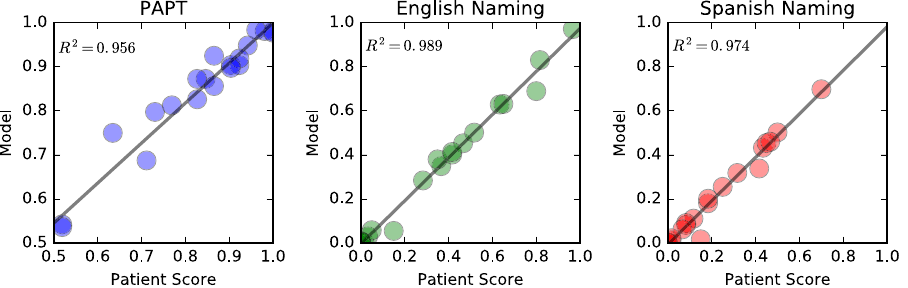
Figure 4. Individual pre-stroke models for each patient are lesioned to match diagnostic scores as accurately as possible. Real vs. simulated scores for all 13 patients are shown for the PAPT test (left), and English (middle) and Spanish (right) picture naming. The resulting models are used as a starting point for treatment simulations.